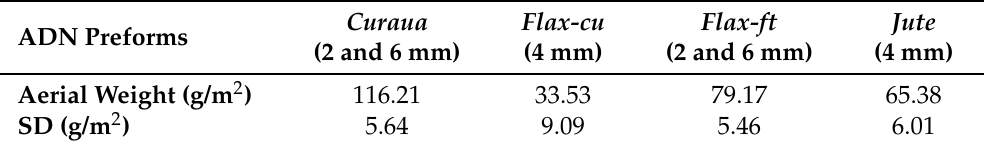
Table 2. Aerial weight of ADN preforms.